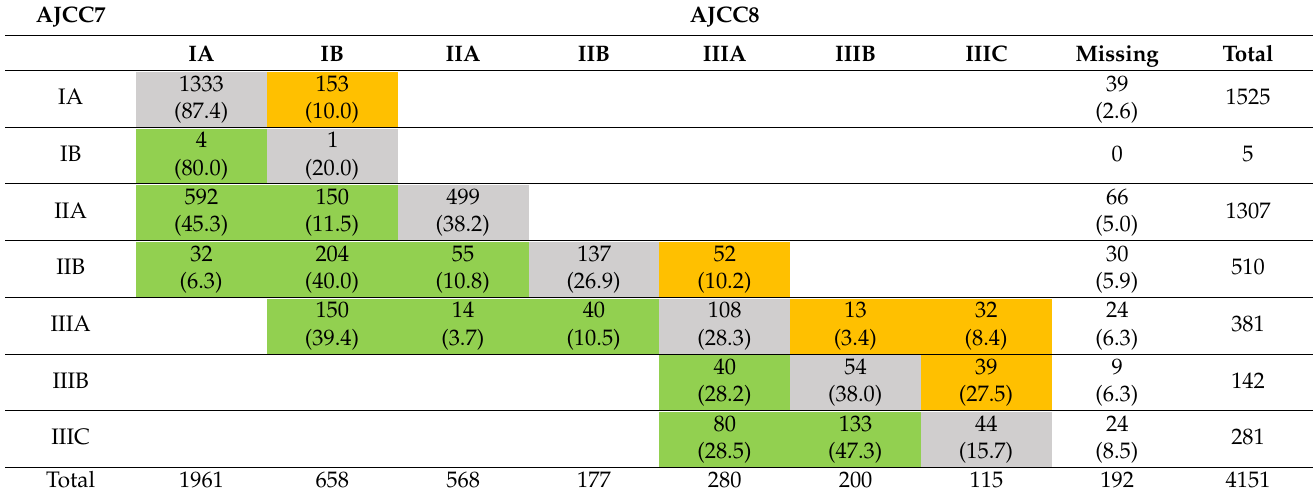
Table 2. Stage at diagnosis for women diagnosed with breast cancer in Malaysia from 2010 to 2020, using AJCC7 (rows) and AJCC8 (column) classification systems